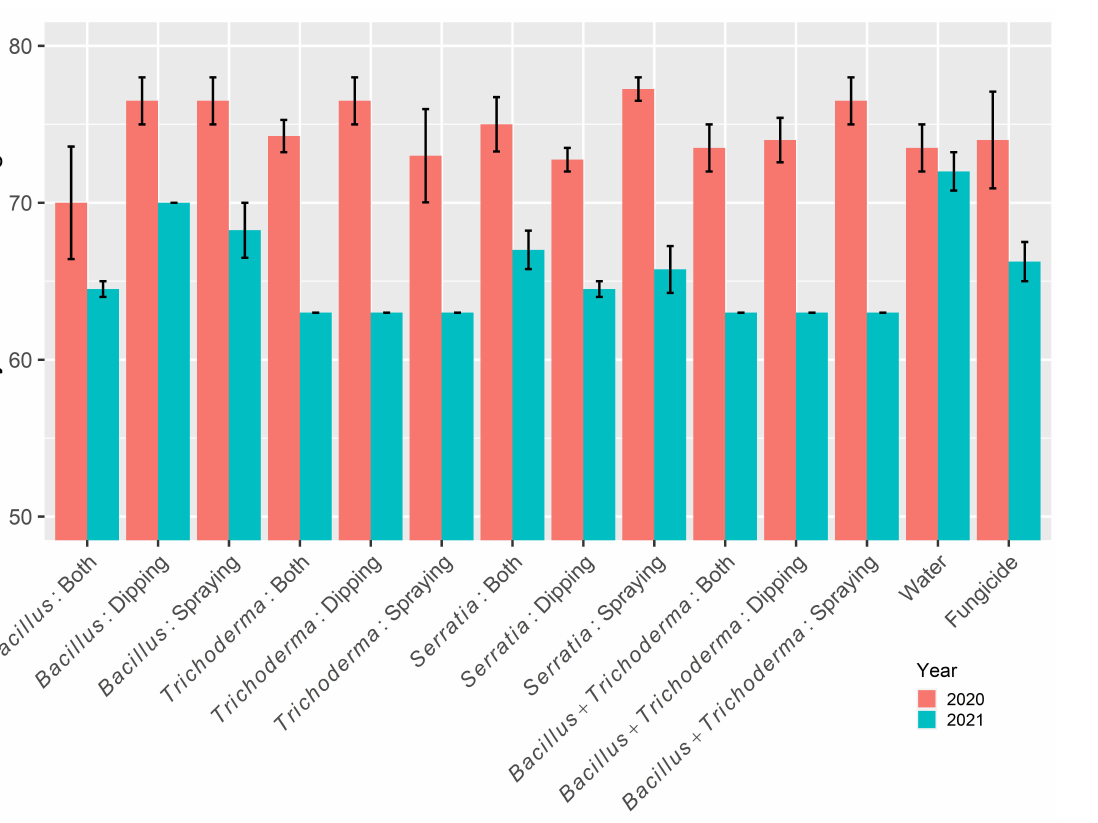
Figure 3. Time (days) from transplanting to first flowering of rice plants that received one of the four biopesticides applied at different times (dipping at transplanting, foliar spraying post-transplanting, or at both times) at one site in 2020 and 2021 in Kenya. Two controls (water as negative, and fungicide as positive) were included for comparison. The bar represents one standard